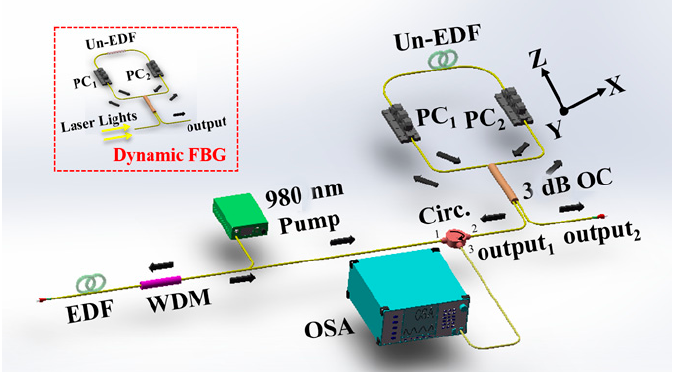
Figure 2. Experimental setup of the gain-flattened EDFA with a Un-EDF.